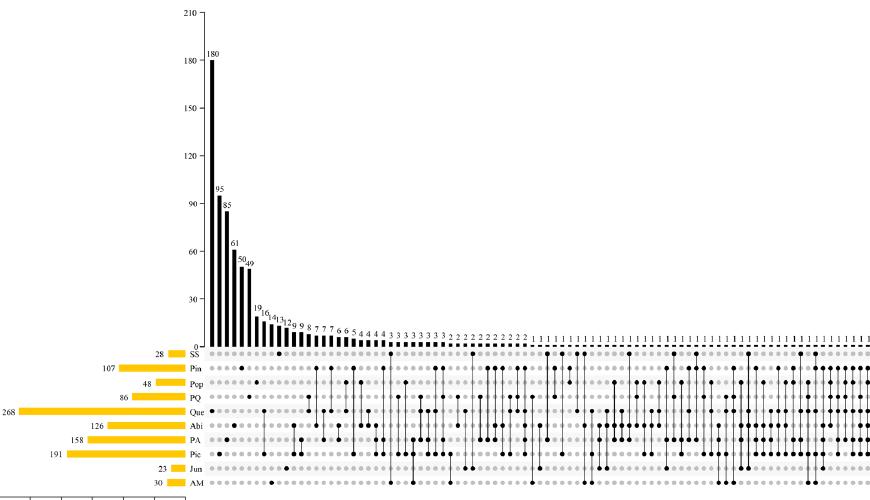
Figure 5. UpSet plots were used to display the overlap between ten vegetation types of macrofungal species. The horizontal bars indicate the number of macrofungal species in each vegetation type, with 28, 107, 48, 86, 268, 126, 158, 191, 23, and 30 species identified in SS, Pin, Pop, PQ, Que, Abi, PA, Pic, Jun, and AM, respectively. The vertical bars display the number of unique and shared species. Specifically, 13, 50, 19, 49, 180, 61, 85, 95, 12, and 14 species were identified as endemic to each veg- etation type and found only in that